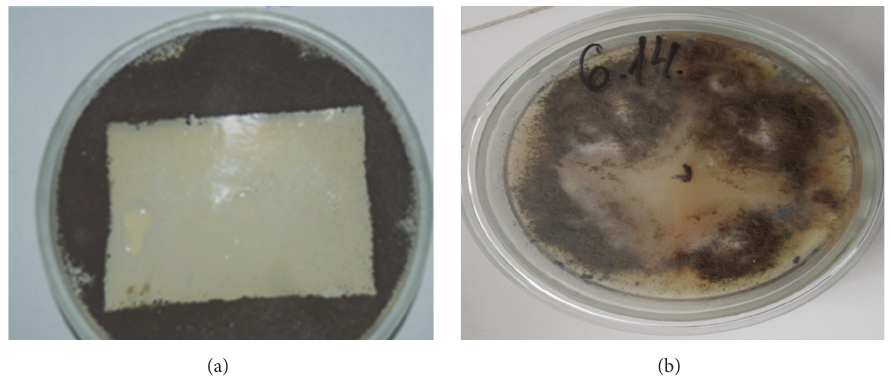
Figure 5: Photograph of LDPE (a) and polymer composition (wt.%) LPPE (89%), PA-6 (10%), and EVA type I (1%) (b), after biodegradation for 28 d on solid media Czapek.